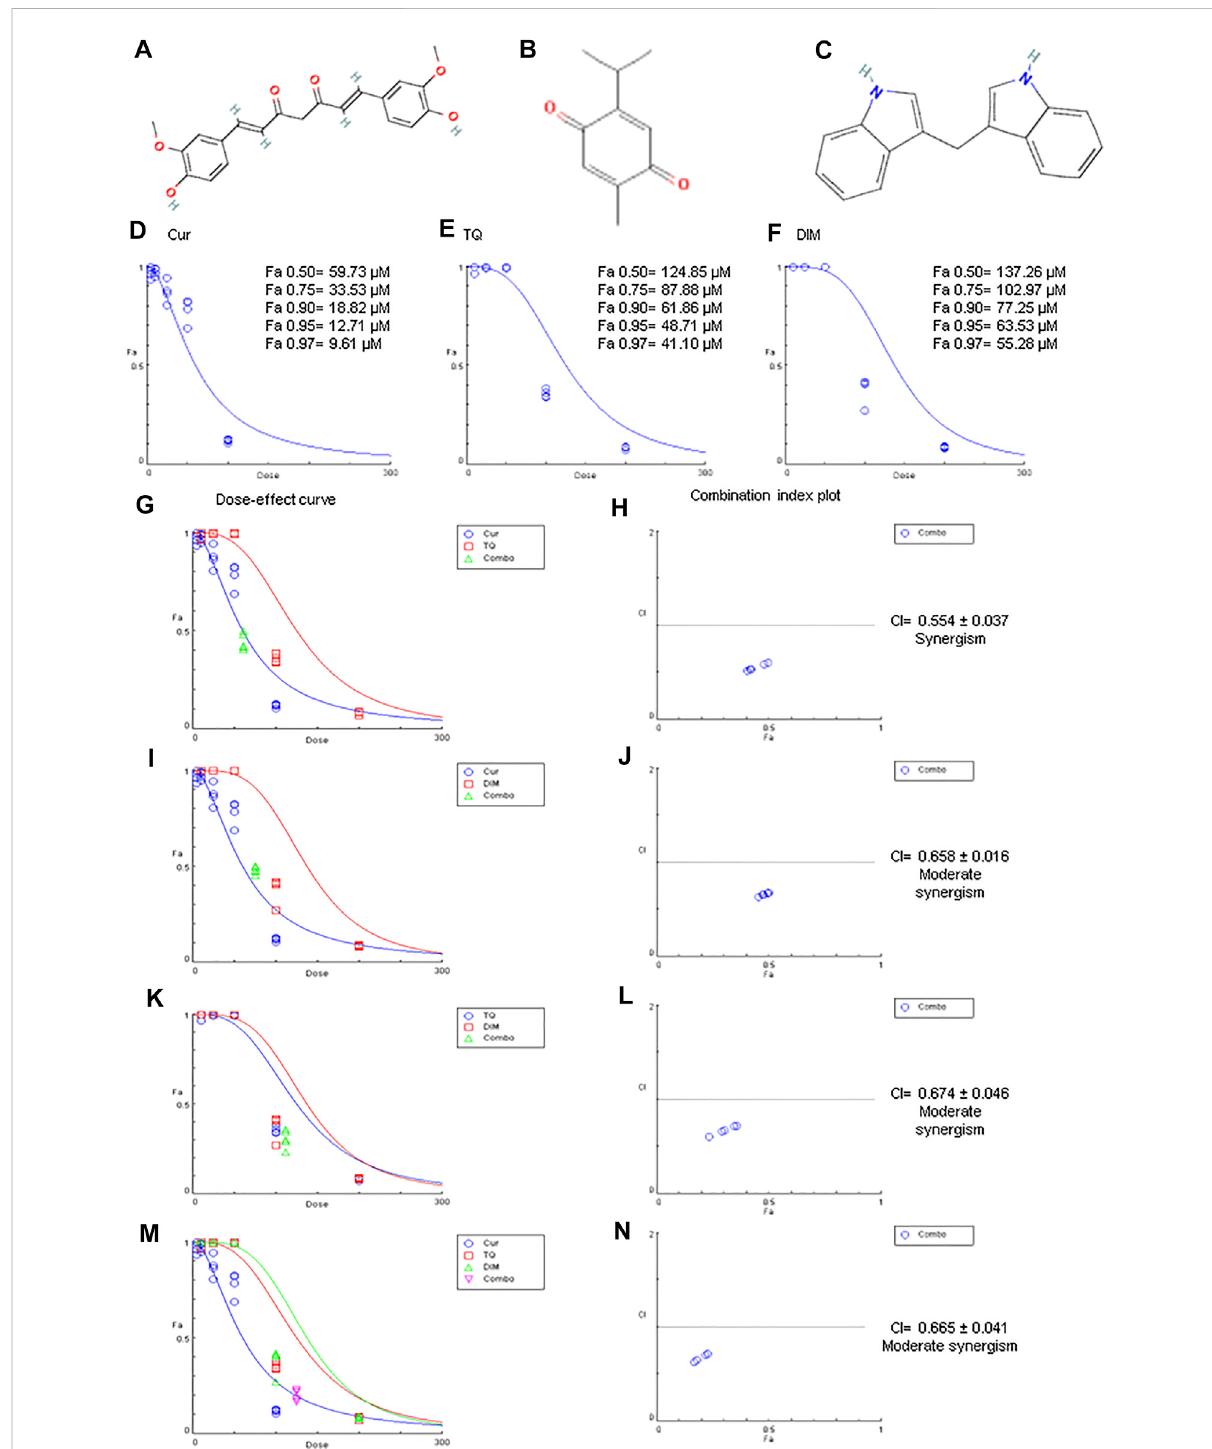
FIGURE 1 Chemical structures, Fa values, and combination index of curcumin (Cur), thymoquinone (TQ), and 3,3 ′ -diindolylmethane (DIM) against A549. (A) Chemical structure of Cur. (B) Chemical structure of TQ. (C) Chemical structure of DIM. (D) Fa values of Cur against A549. (E) Fa values of TQ against A549. (F) Fa values of TQ against A549. (G) Dose-effect curve of Fa 95 of Cur (12.71 µM) and TQ (48.71 µM). (H) Combination index plot of Fa 95 of Cur and TQ. (I) Dose-effect curve of Fa 95 of Cur (12.71 µM) and DIM (63.53 µM). (J) Combination index plot of Fa 95 of Cur and DIM. (K) Dose-effect curve of Fa 95 of TQ (48.71 µM) and DIM (63.53 µM). (L) Combination index plot of Fa 95 of TQ and DIM. (M) Dose-effect curve of Fa 95 of Cur (12.71 µM), TQ (48.71 µM), and DIM (63.53 µM). (N) Combination index plot of Fa 95 of Cur, TQ, and DIM. The CI values represent the mean of four experiments. CI > 1.3: antagonism; CI (1.1 – 1.3): moderate antagonism; CI (0.9 – 1.1): additive effect; CI (0.8 – 0.9): slight synergism; CI (0.6 – 0.8): moderate synergism; CI (0.4 – 0.6): synergism; CI (0.2 – 0.4): strong